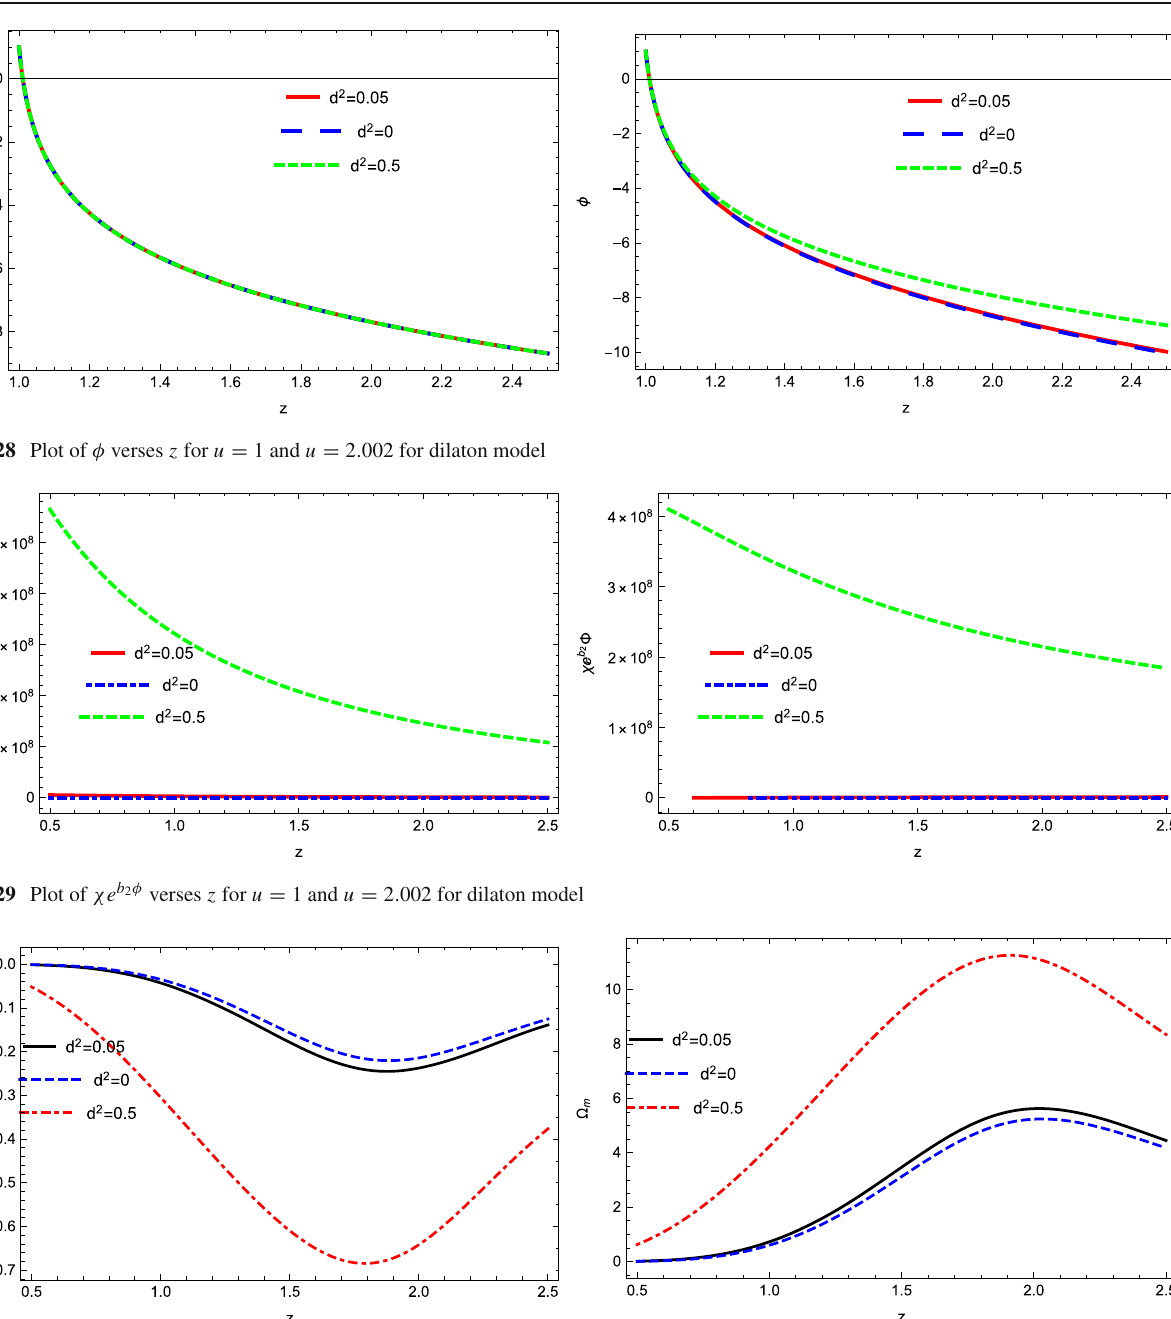
workofGR.Wehavereconstructedtwocosmologicalparam- eters with the suitable choice of interacting parameter d 2